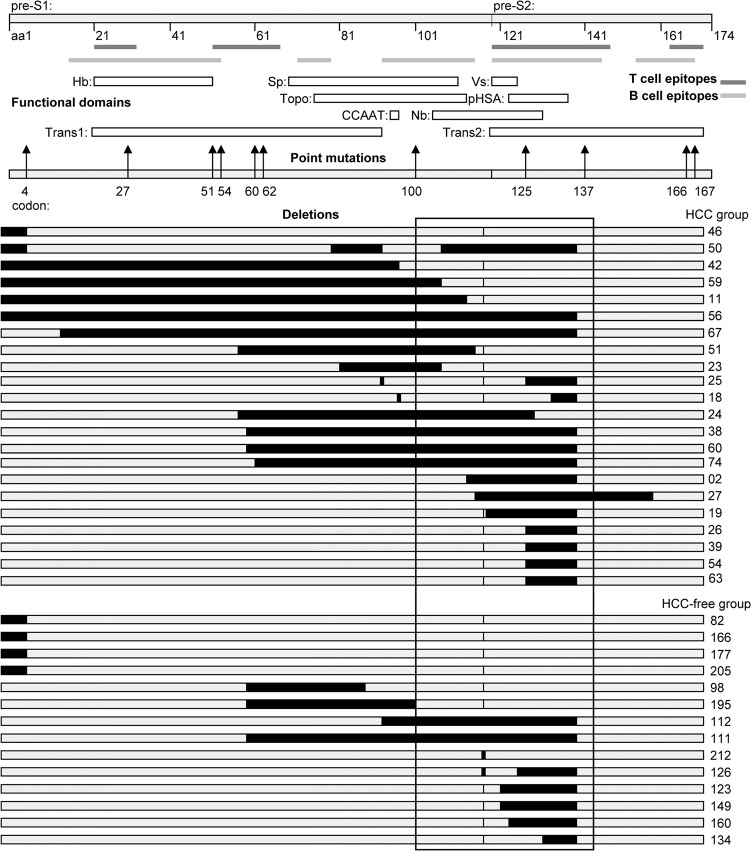
Mapping of pre-S mutations in HCC patients and HCC-free patients.The HBV pre-S region contains immune epitopes and functional domains as depicted. The B-cell epitopes located at aa12-53, aa72-78, aa94-117, aa120-143 and aa157-167 of pre-S gene (overlap regions merged); The T-cell epitopes located at aa21-30, aa52-67, aa120-145 and aa163-172 of pre-S gene (overlap regions merged). The functional domains include the start codons of pre-S1 (aa1) and pre-S2 (aa120), hepatocyte binding site (Hb, aa21-47), S promoter (Sp, nt3045-3180), CCAAT box (nucleotide 3137–3141), topology domain (Topo) includes heat shock protein 70 binding site (aa74-118) and cytosolic anchorage determinant (aa81-105), nucleocapsid binding site (Nb, aa103-127), viral secretion domain (Vs, aa120-124), polymerized human serum albumin binding site (pHSA, aa122-135), transactivator domain (Trans, aa21-90, 120–172). The sequence of each sample is depicted as a block. The black blocks inside represent the deletions of amino acids. The patient identifier numbers are listed at the right.